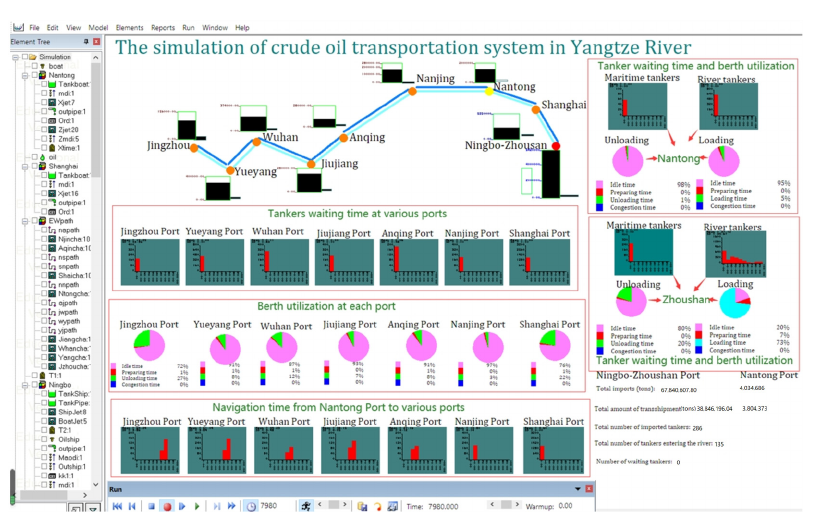
Figure 7. Graphical visualization of the system simulation model.